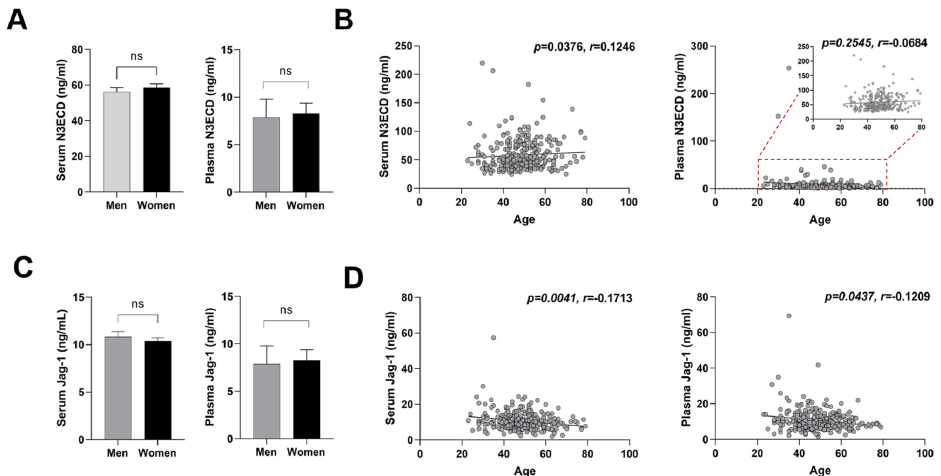
Figure 3. Comparison of mean N3ECD and Jagged-1 levels by gender and age. Serum and plasma N3ECD levels between male and female ( A ) and correlations between N3ECD levels and age ( B ). Jagged-1 serum and plasma levels in male and female ( C ) and correlations with age ( D ). Each symbol represents values from a single subject; midline represents the mean; and error bars represent the standard error. The resulting Spearman’s correlation coefficient ( r ) and corresponding p -value are reported. ns—not significant.